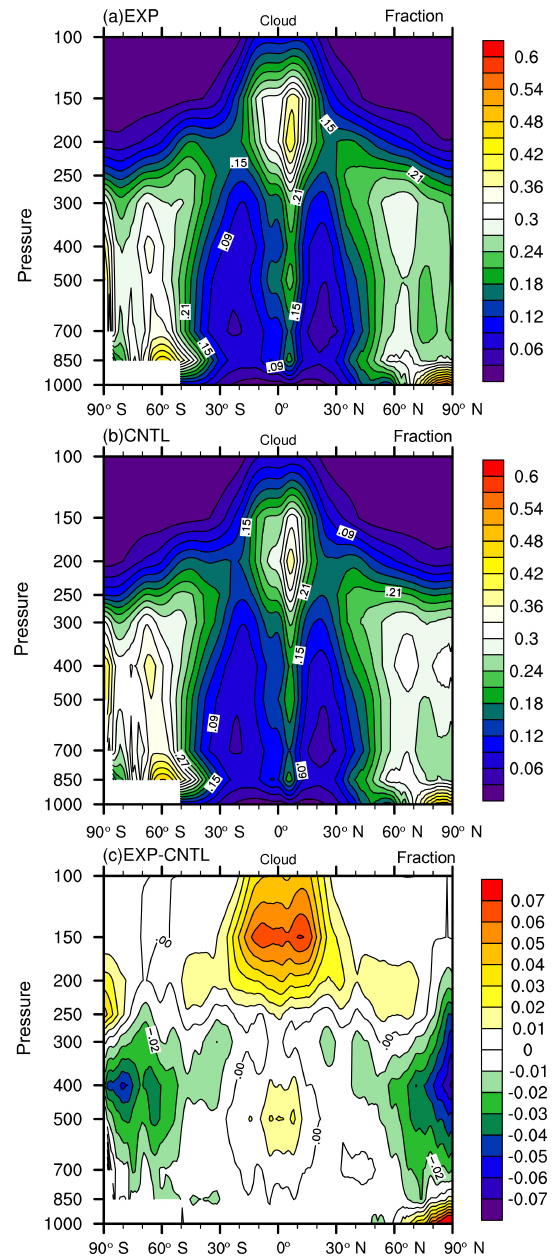
Figure 6. Pressure–latitude distributions of cloud fraction in (a) EXP, (b) CNTL, and (c) EXP –